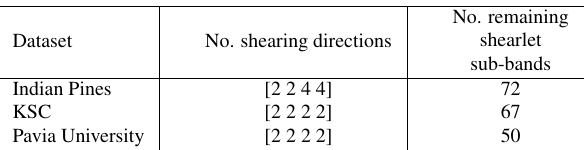
Table 4. NSST-KMNF setup of three datasets